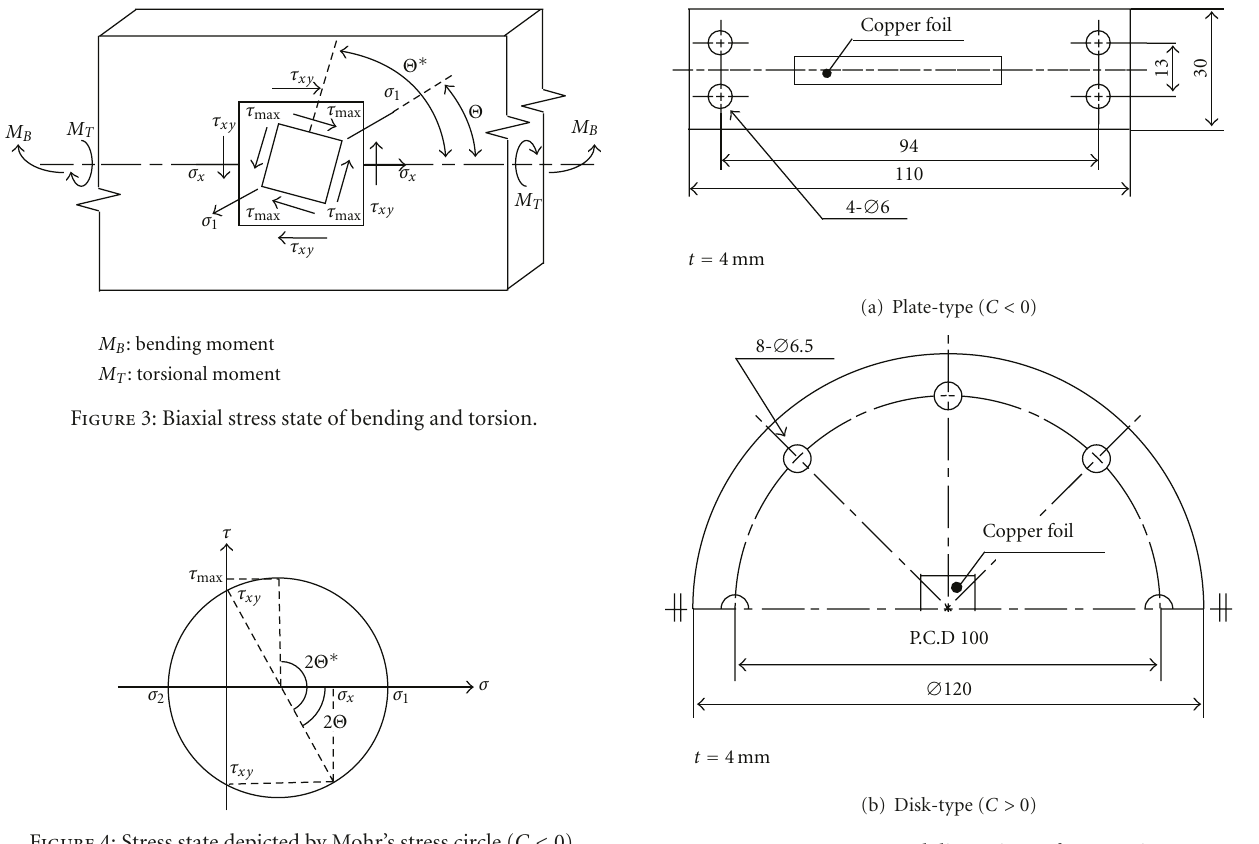
Figure 5: Geometry and dimensions of test